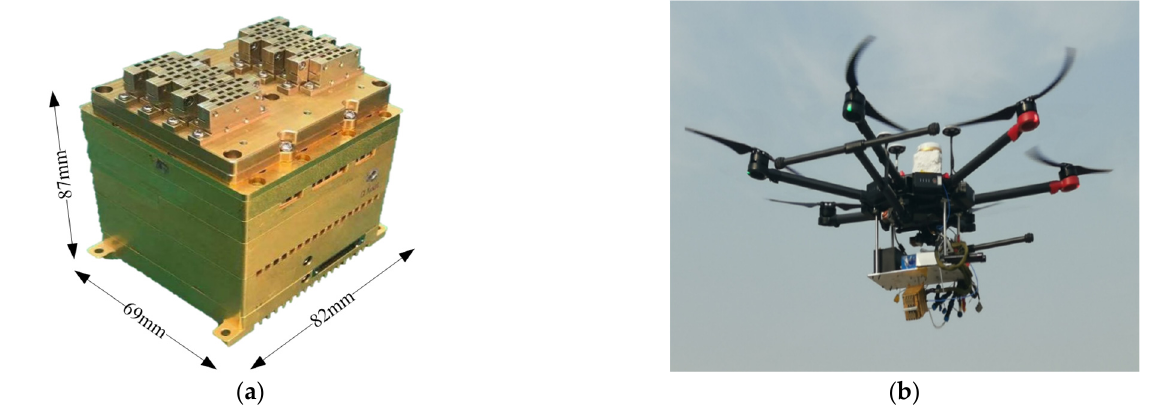
Figure 13. The W-Band APA mini-SAR and the photography on UAV. ( a ) The prototype of the W-Band APA mini-SAR. ( b ) The W-Band APA mini-SAR on the UAV platform.